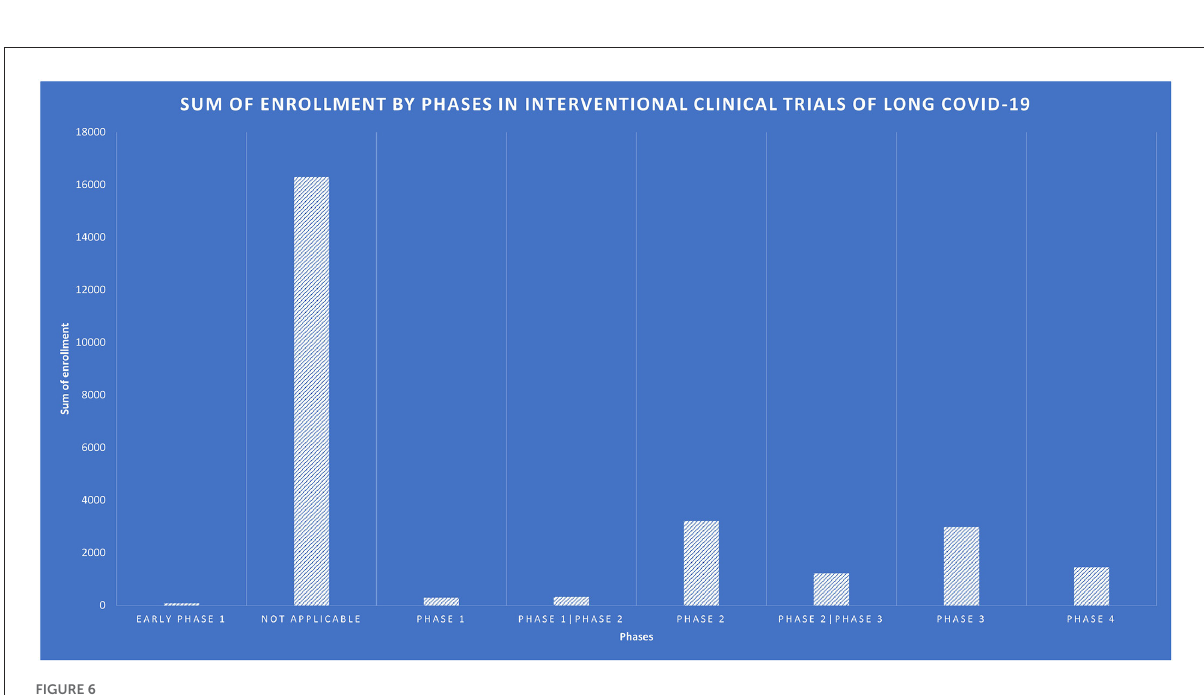
FIGURE6 Sum of enrollment by phases in interventional clinical trials of long